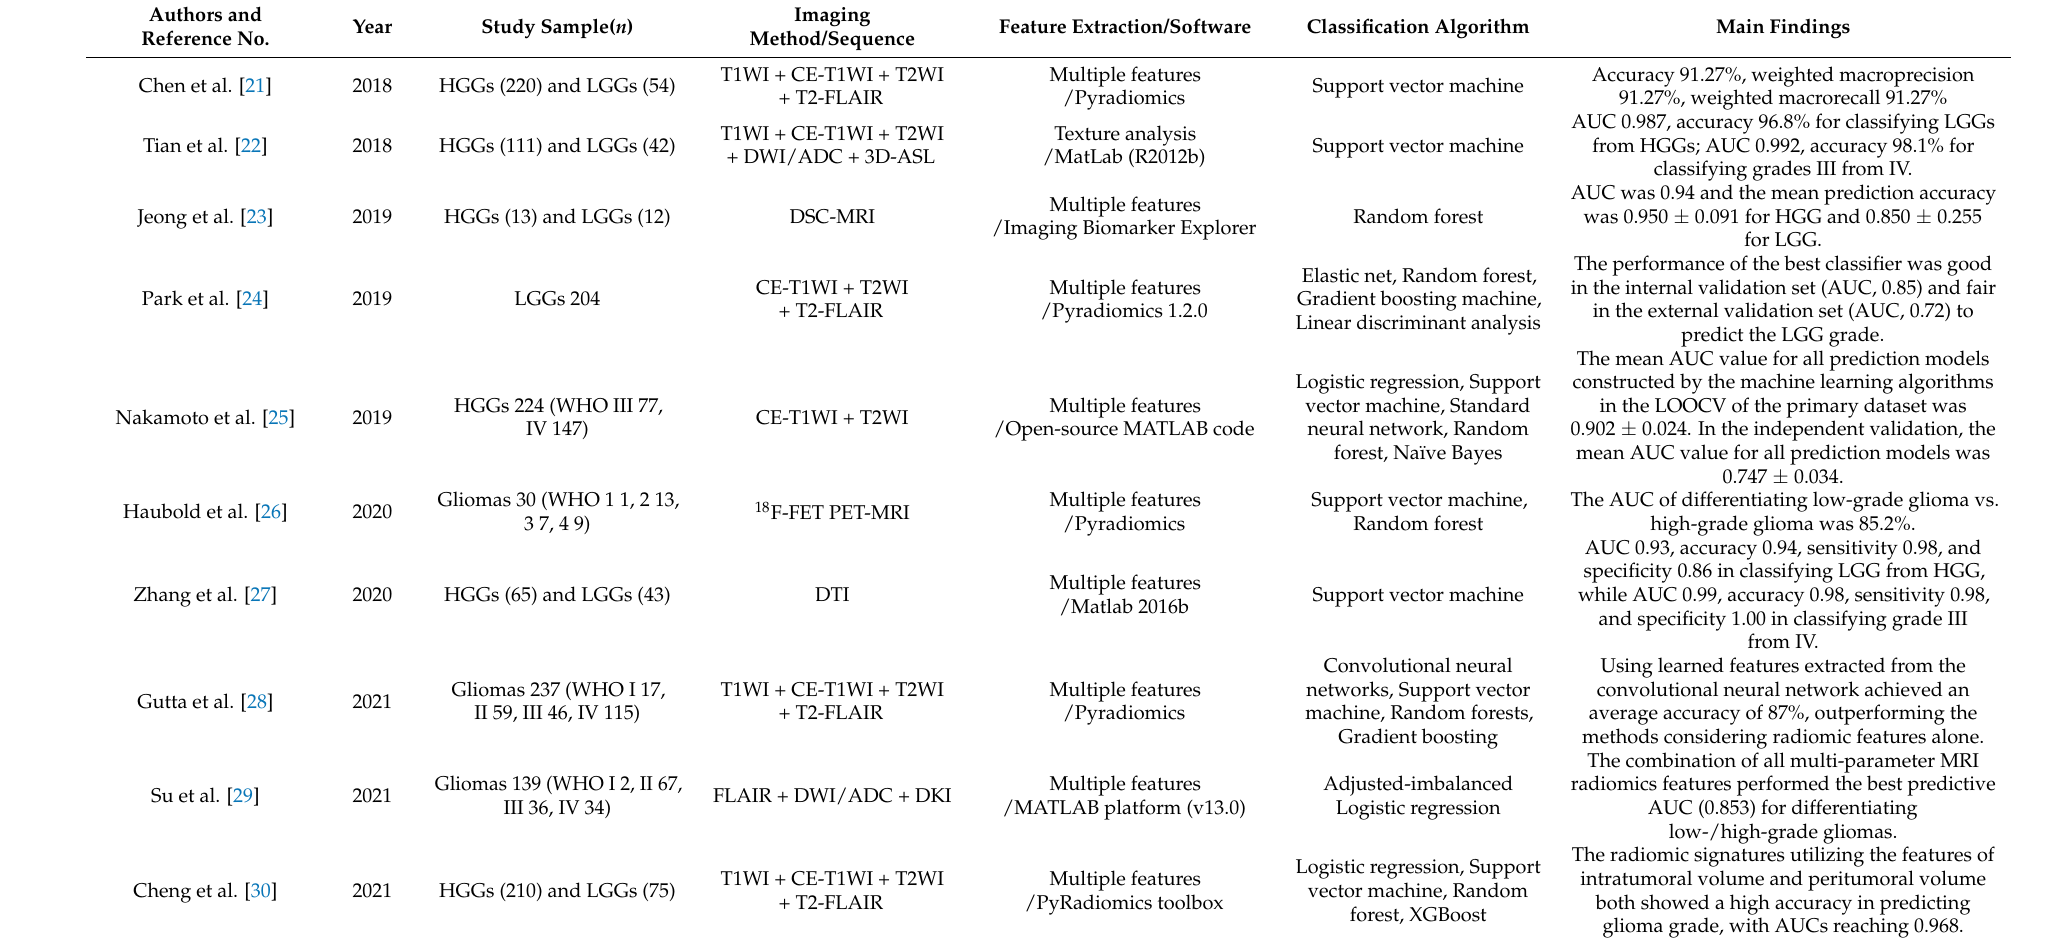
Table 2. Studies Investigating the Role of Radiomics in Preoperative Grading Adult